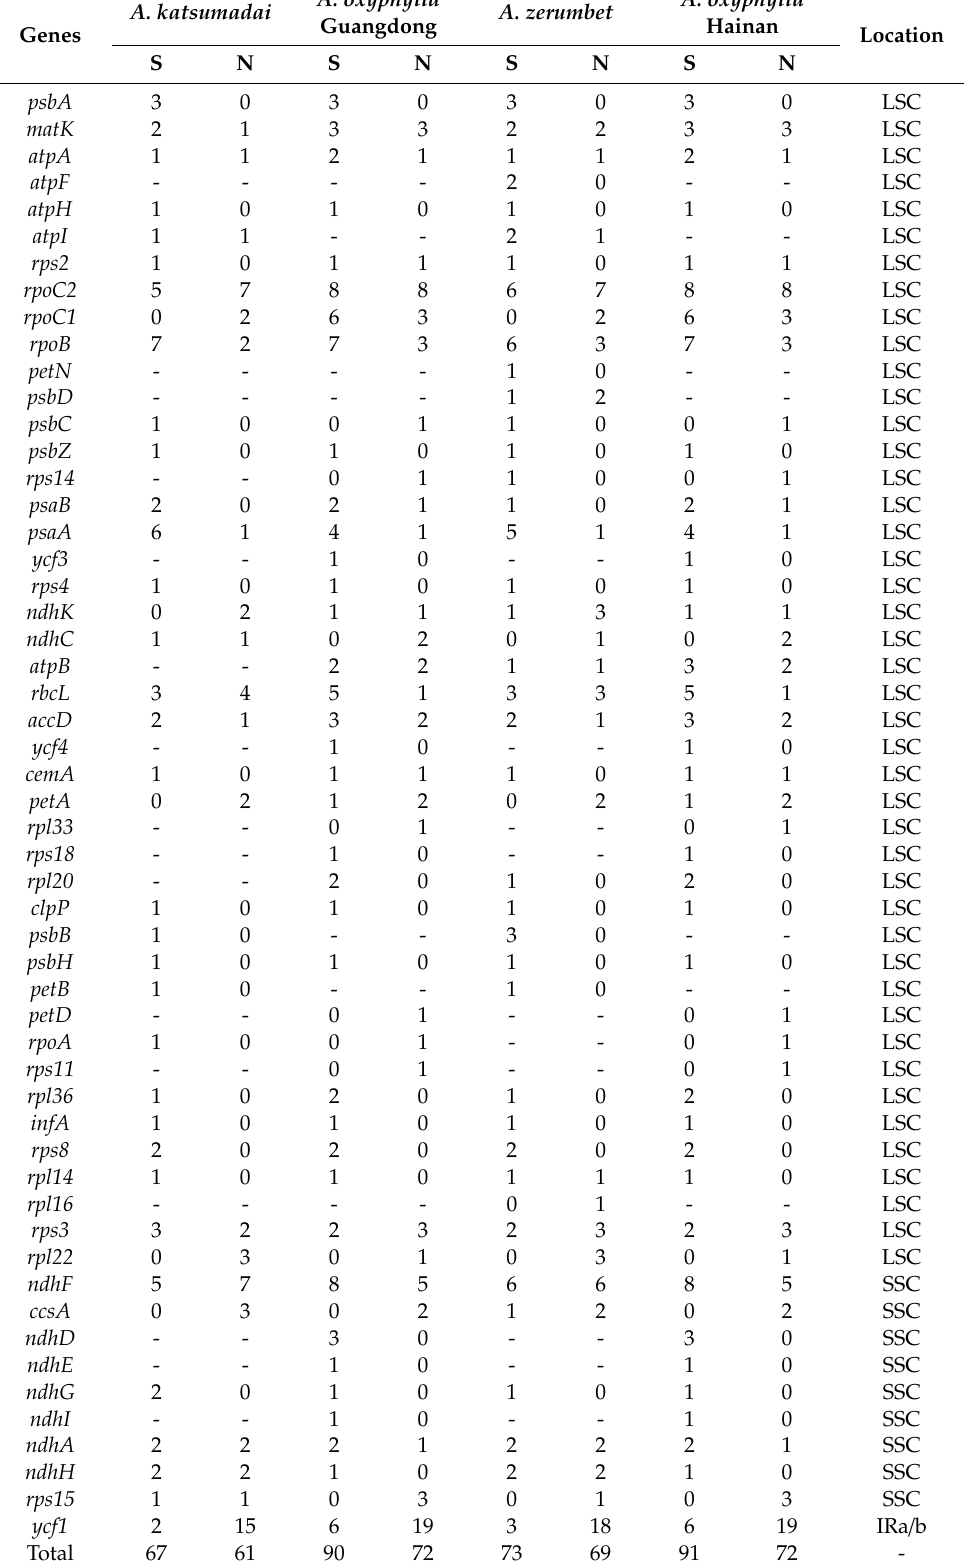
Table 3. Comparisons of mutation changes, number of synonymous (S) and nonsynonymous (N) substitutions per gene of protein-coding genes among four Alpinia chloroplast genomes.